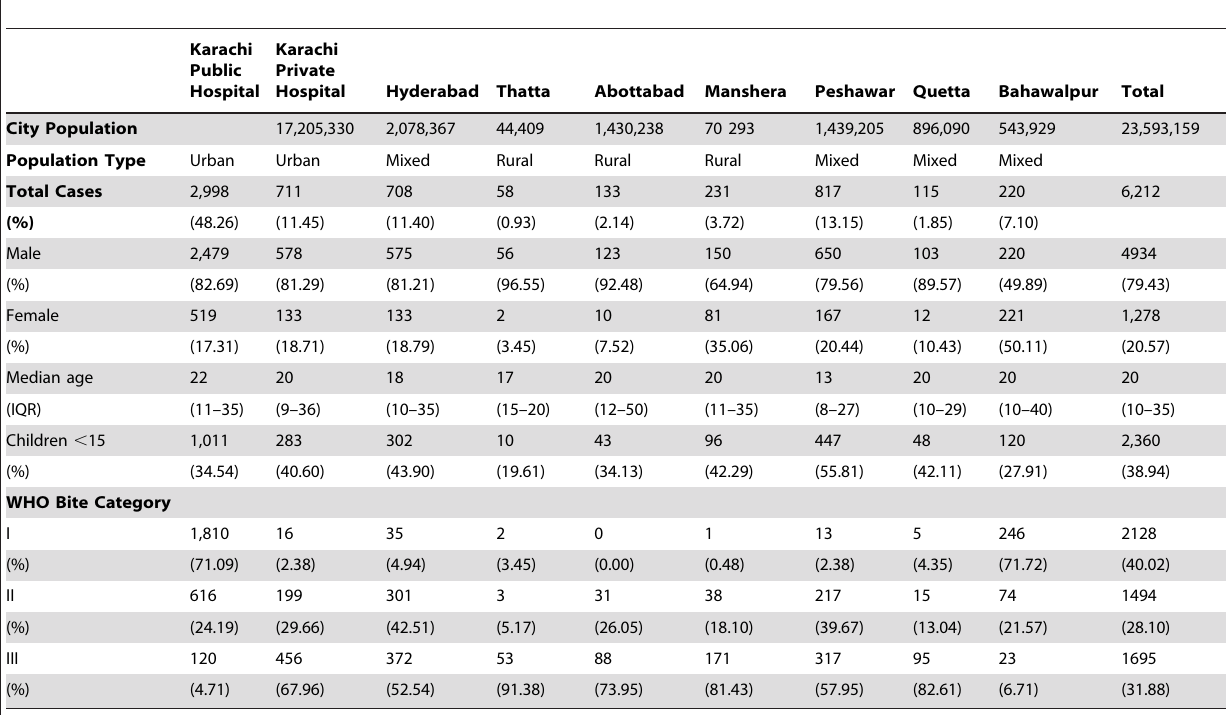
Table 1. Characteristics of dog-bite victims identified through screening at nine emergency rooms in Pakistan (Feb 2009–Feb